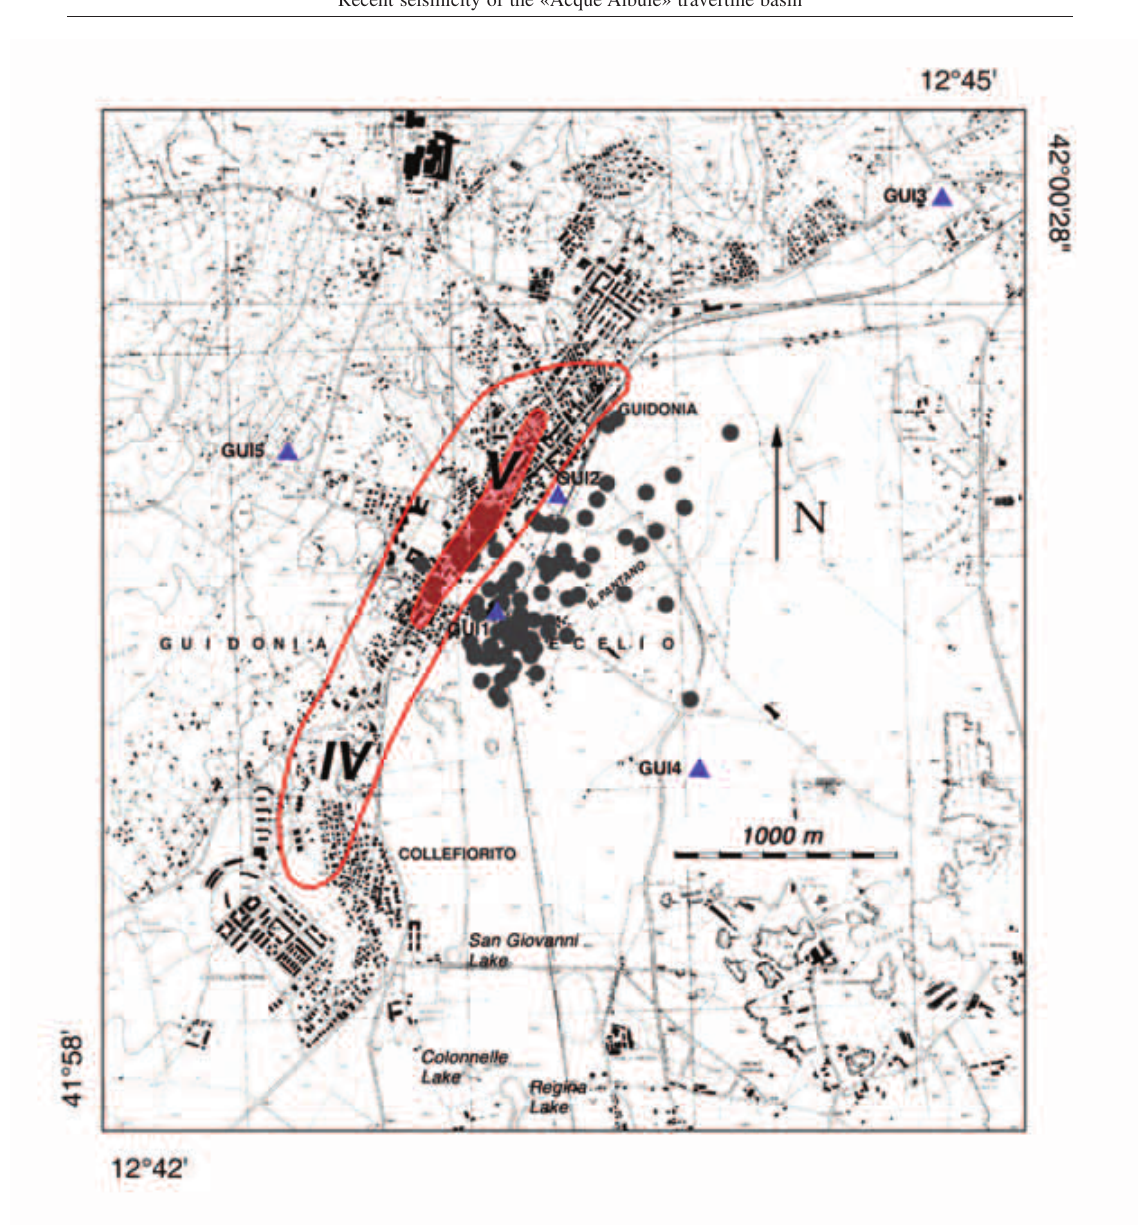
Fig. 4. Macroseismic investigation of the event which occurred on June 22, 2001 at 4:36 p.m. GMT, in addition the distribution of the events, occurring during the period May-June 2001 and recorded by the INGV mobile